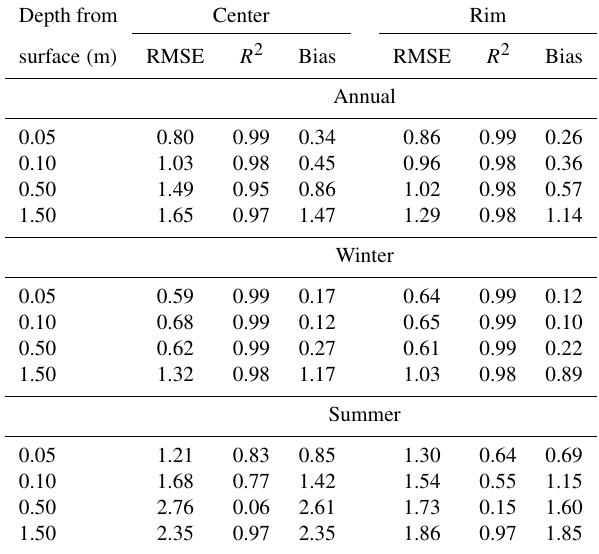
Table 6. Model performance statistics at Site D compared to ob- served soil temperatures (for annual, winter and summer periods). The model shows higher bias during the summer season compared to winter. Depth from Rim surface ( m